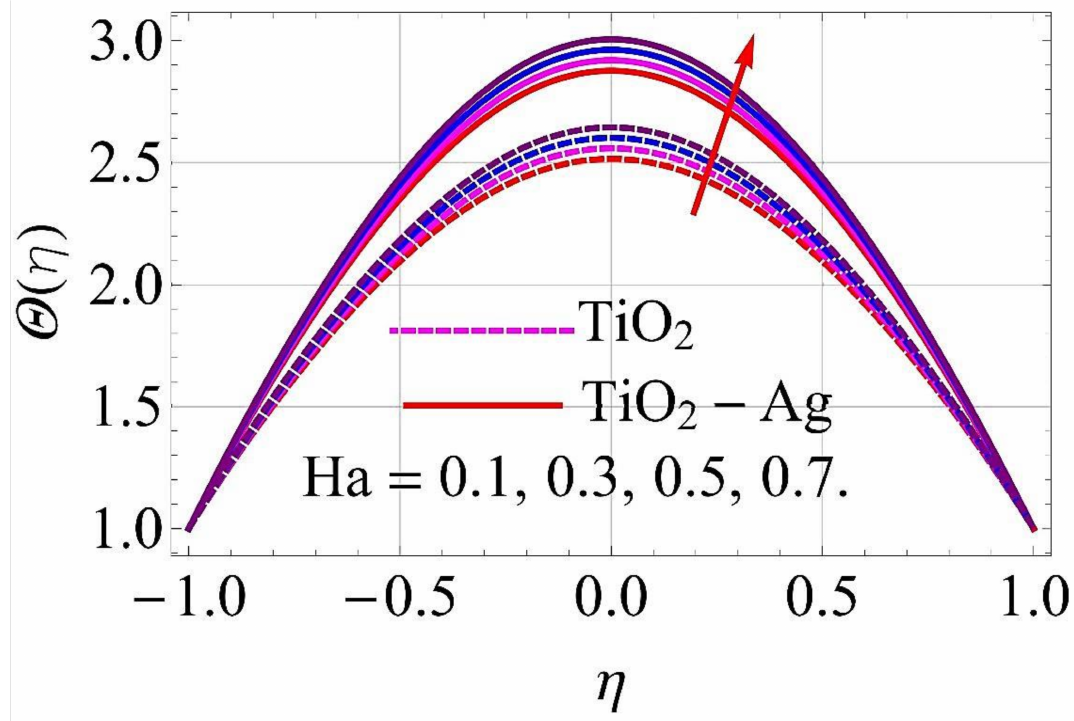
Figure 18. Temperature versus Ha with α = 5 ◦ for diverging/shrinking circumstances. When Re = 25, φ 1 = φ 2 = 0.01, Rd = 0.4, Ec = Q = k ∗ = Fr = K 1 =